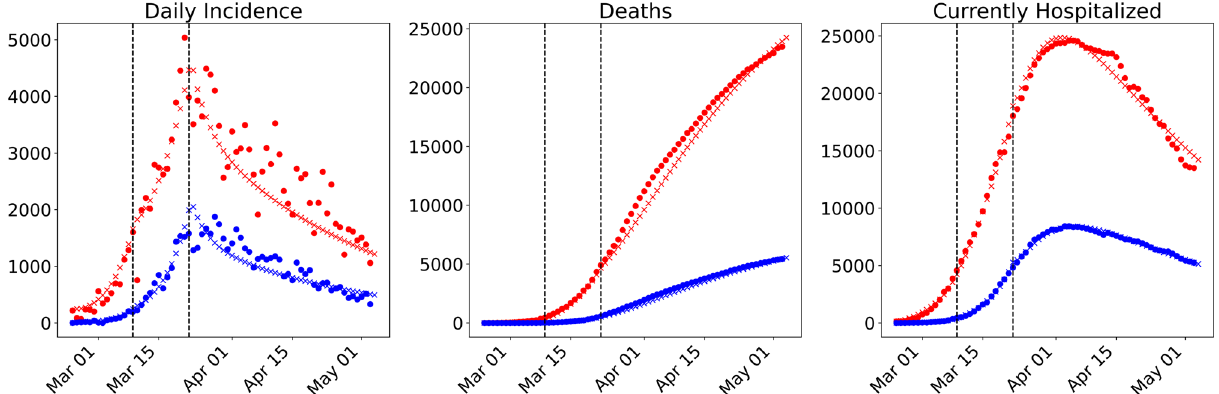
Figure 6. Model fit for the early dynamics of the COVID-19 outbreak in Italy. Reported data (dots) and model results (crosses) for daily incidence (left panel), deaths (middle panel) and hospitalized cases (right panel) in region A (Lombardy, Emilia-Romagna, Marche, Piedmont, Veneto; red) and region B (rest of the country; blue). Parameter values are estimated as indicated in three different time intervals (separated by vertical lines in the